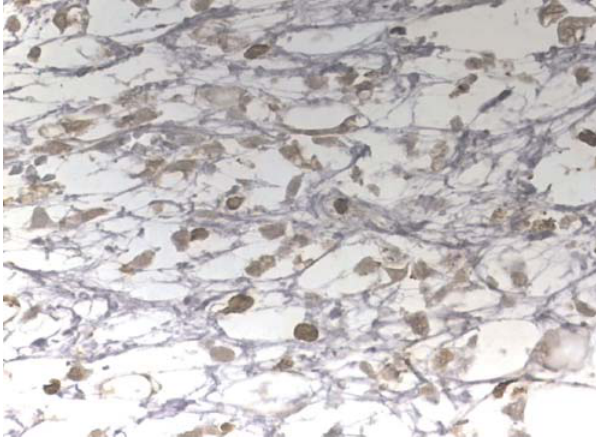
Figure 1 - Photomicrograph showing a positive immunohistochemical result for the presence of MDM2 protein (magnification 400